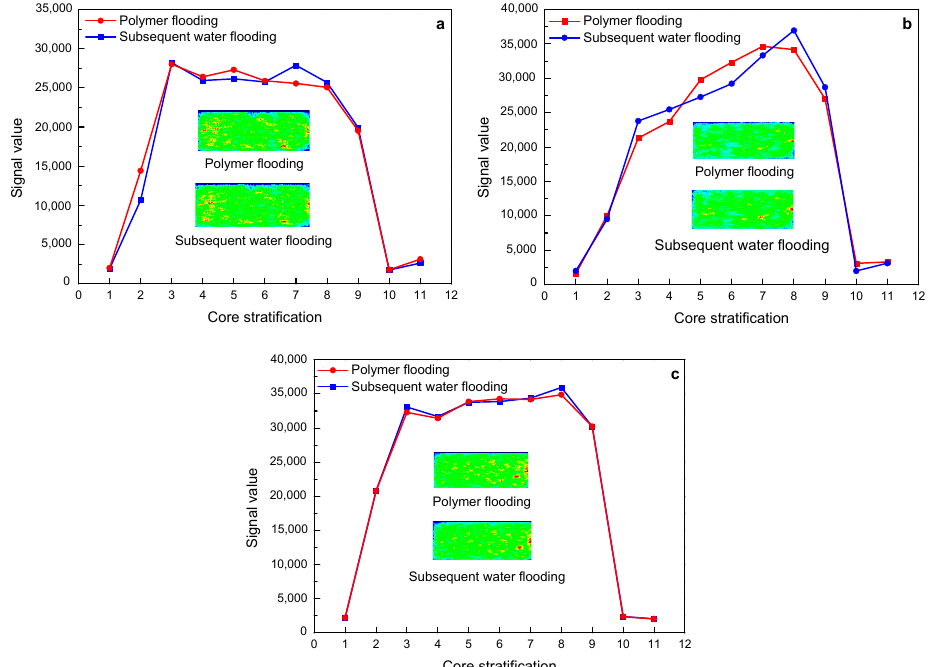
Figure 13. The change characteristics of NMR layering signal and imaging of 19 million molecular weight polymer solutions in rock cores with different permeability after polymer flooding and sub- sequent water flooding: ( a ) 500 mD core; ( b ) 1000 mD core; ( c ) 2000 mD core.